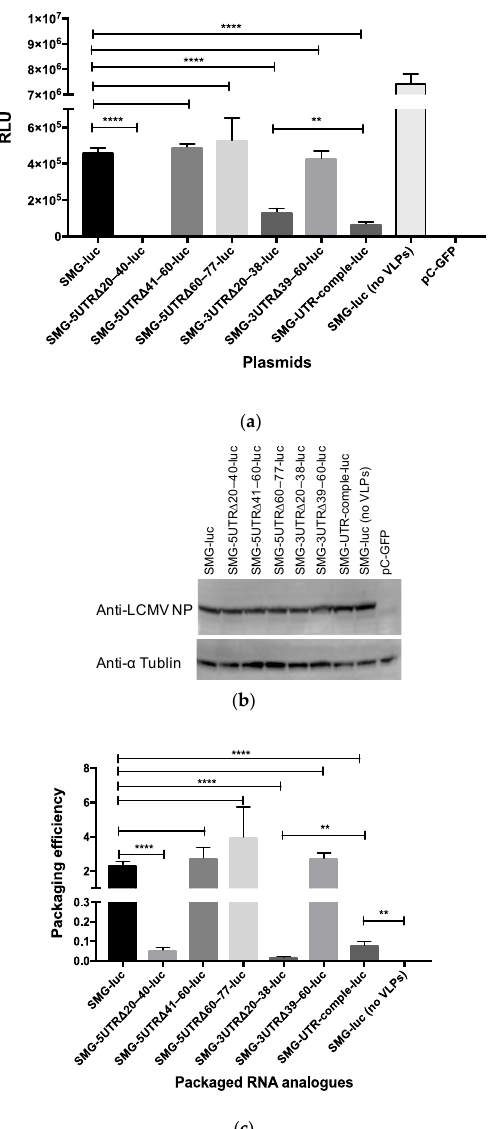
Figure 7. Evaluation of the efficiency of viral genome transcription, replication, and packaging in virus-like particles (VLPs): ( a ) Viral genome transcription and replication were assessed in BHK-21 cells transfected with SMG-luc, SMG-5UTR ∆ 20–40-luc, SMG-5UTR ∆ 41–60-luc, SMG-5UTR ∆ 60–77-luc, SMG-3UTR ∆ 20–38-luc, SMG-3UTR ∆ 39–60-luc, or SMG-UTR-comple-luc under conditions of the co-expression of NP, L protein, GPC, and Z protein. BHK-21 cells were transfected with each mutated SMG-luc, pC-NP, pC-L, pC-Z, and pC-GPC. As a background control for the rescue of LCMV RNA analogs into VLPs, cells transfected with SMG-luc, pC-NP, and pC-L were used (SMG-luc (no VLPs)). After incubation for 48 h at 37 °C with 5% CO2, luciferase expression was examined. ( b ) The expressions of LCMV NP and α tublin in transfected cells were confirmed by Western blot analysis. ( c ) Packaging of viral genome RNA analogs derived from SMG-luc, SMG-5UTR ∆ 20–40-luc, SMG-5UTR ∆ 41–60-luc, SMG-5UTR ∆ 60–77-luc, SMG-3UTR ∆ 39–60-luc, or SMG-UTR-comple-luc into VLPs were assessed. Supernatants from each well of Figure 7a were harvested and used to infect fresh monolayers of BHK-21 cells, which were then incubated for 4 h at 37 °C before adding helper LCMV. Ninety hours postinfection, the passage culture was examined for luciferase expression. The packaging efficiency of each SMG was determined by dividing the relative light units (RLUs) value obtained from the passage culture 90 h postinfection by the RLUs value obtained in Figure 7a. (** p < 0.01, and **** p < 0.0001). Error bars indicate standard deviations. All experiments shown were conducted three times independently.